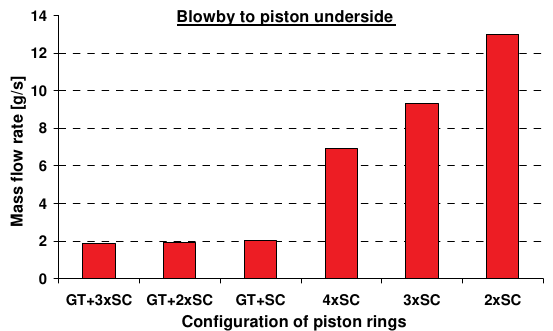
Fig. 11. Comparison of blowby for different ring pack configurations. Lock of the top piston ring: SC – straight-cut, GT –